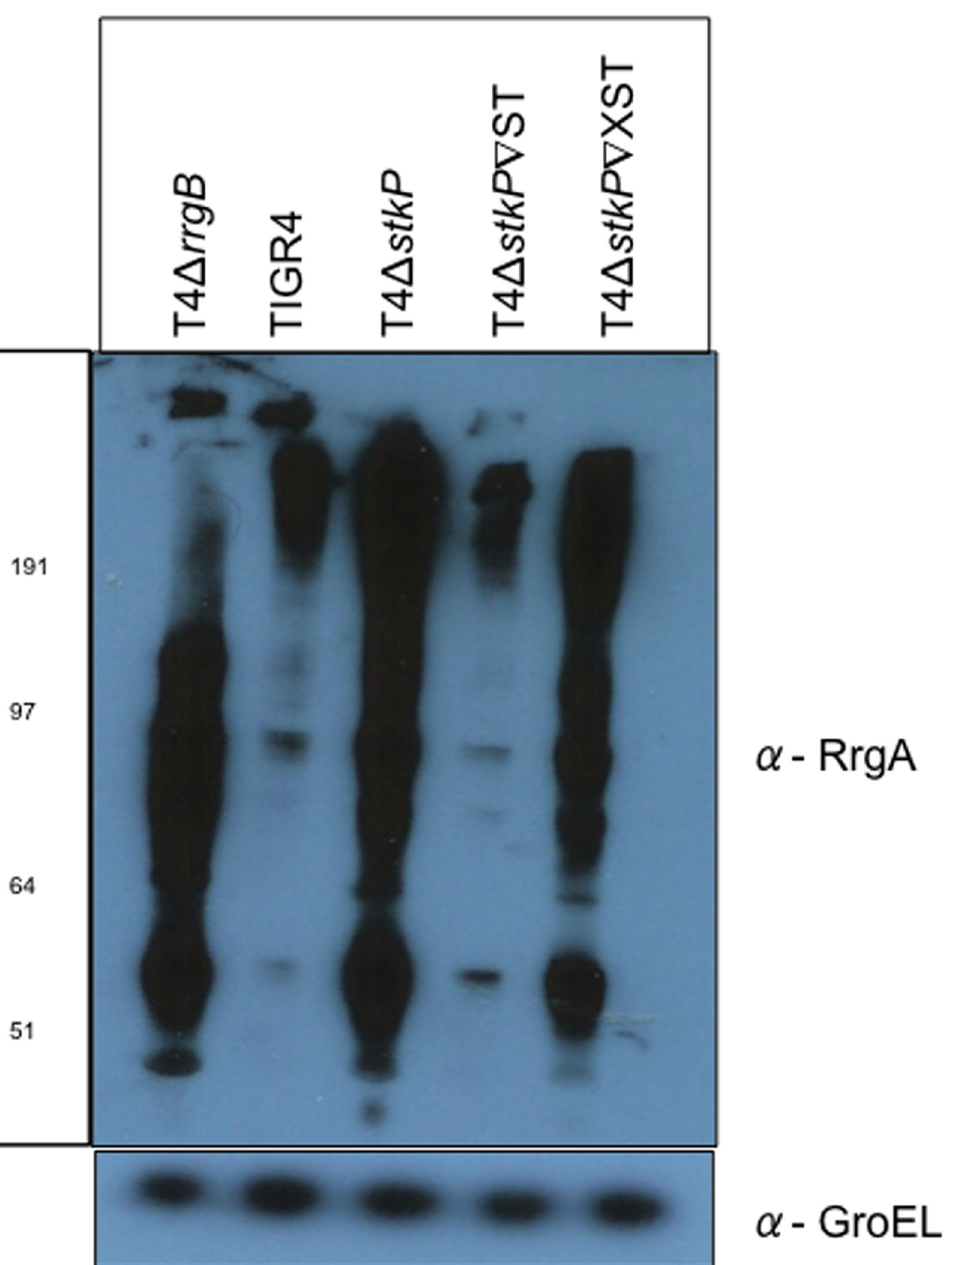
Fig 2. RrgA protein expression in T4 Δ stkP and StkP complemented strains. Western blotting analysis was performed on TIGR4, T4 Δ stkP , T4 Δ stkP r ST, T4 Δ stkP r XST and T4 Δ rrgB at OD 0.6 (OD 600nm ) looking at expression of RrgA in all strains ( α -RrgA antibody). Equal protein loading was confirmed by equal expression of GroEL ( α -GroEL